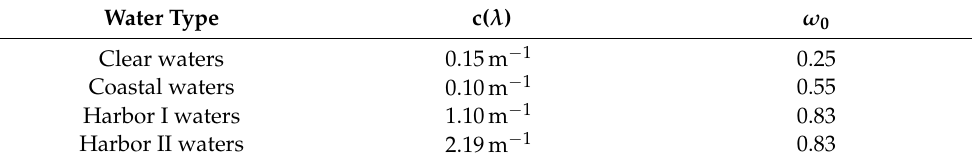
Table 2. Attenuation coefficient and albedo considered for different water types